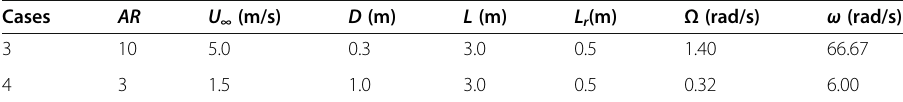
Table 3 Simulation parameters for the single-blade Magnus rotor Cases